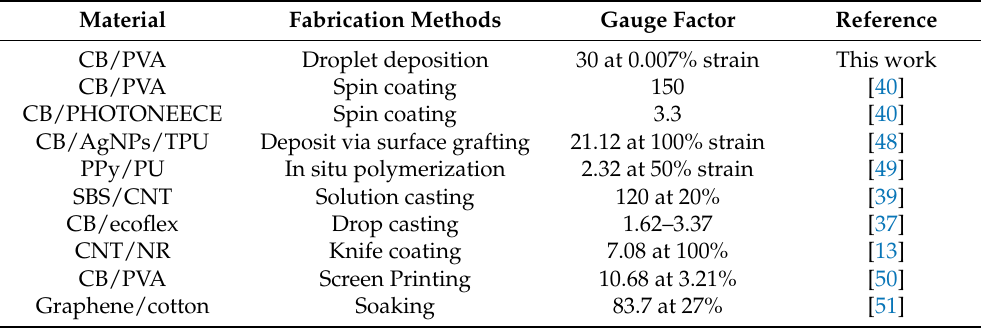
Table 1. The previously reported GFs of strain sensors based on different sensitive materials or different film-forming methods are